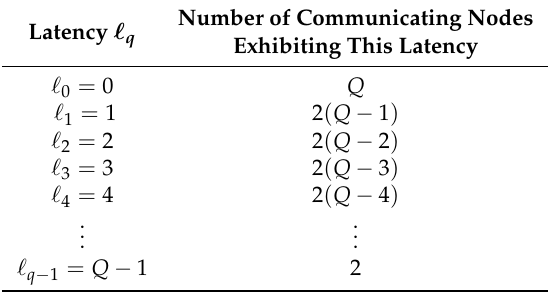
Table 2. Communication latencies among Q 2 node